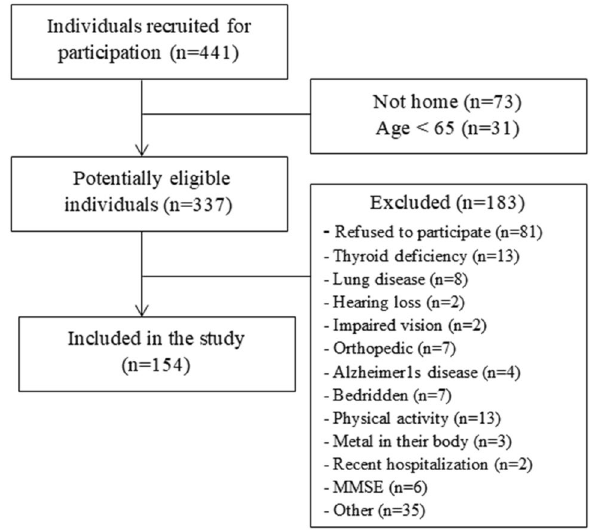
Figure 1. Flowchart of the study.